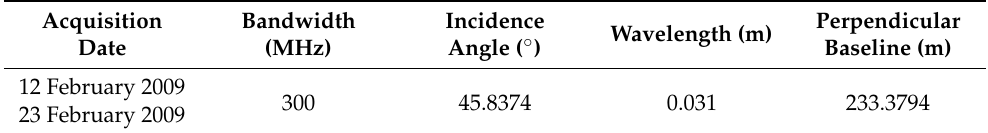
Table 2. The Major Parameters of The Realistic Sar Image